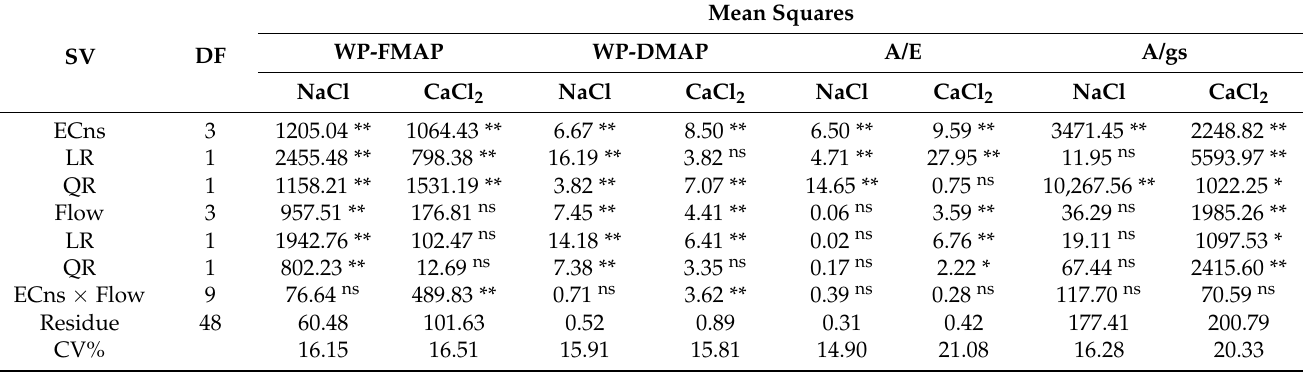
Table 3. Mean squares (MS) analysis of variance (ANOVA) for water productivity based on the production of fresh (WP-FMAP) and dry (WP-DMAP) mass of aerial part, instantaneous (A/E), and intrinsic (A/gs) water use efficiency of coriander plants, cv. Verd ã o, exposed to different levels of electrical conductivity and nutrient solution flow rate under cationic prevalence of NaCl and CaCl 2 .2H 2